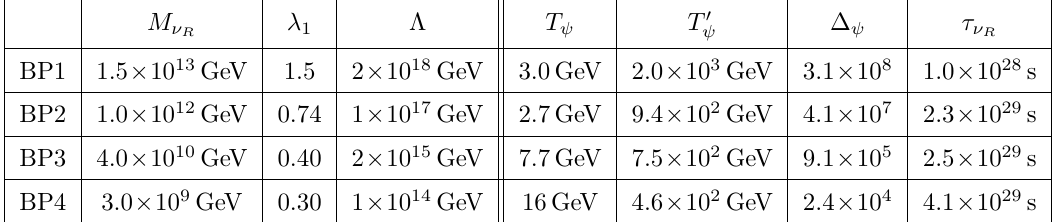
= 1 . 9 M ψ , R (RHN mass), λ 1 ( ν R - ψ - S R are derived, see the text. R = 2891 . 2 cm − 3 are current 0